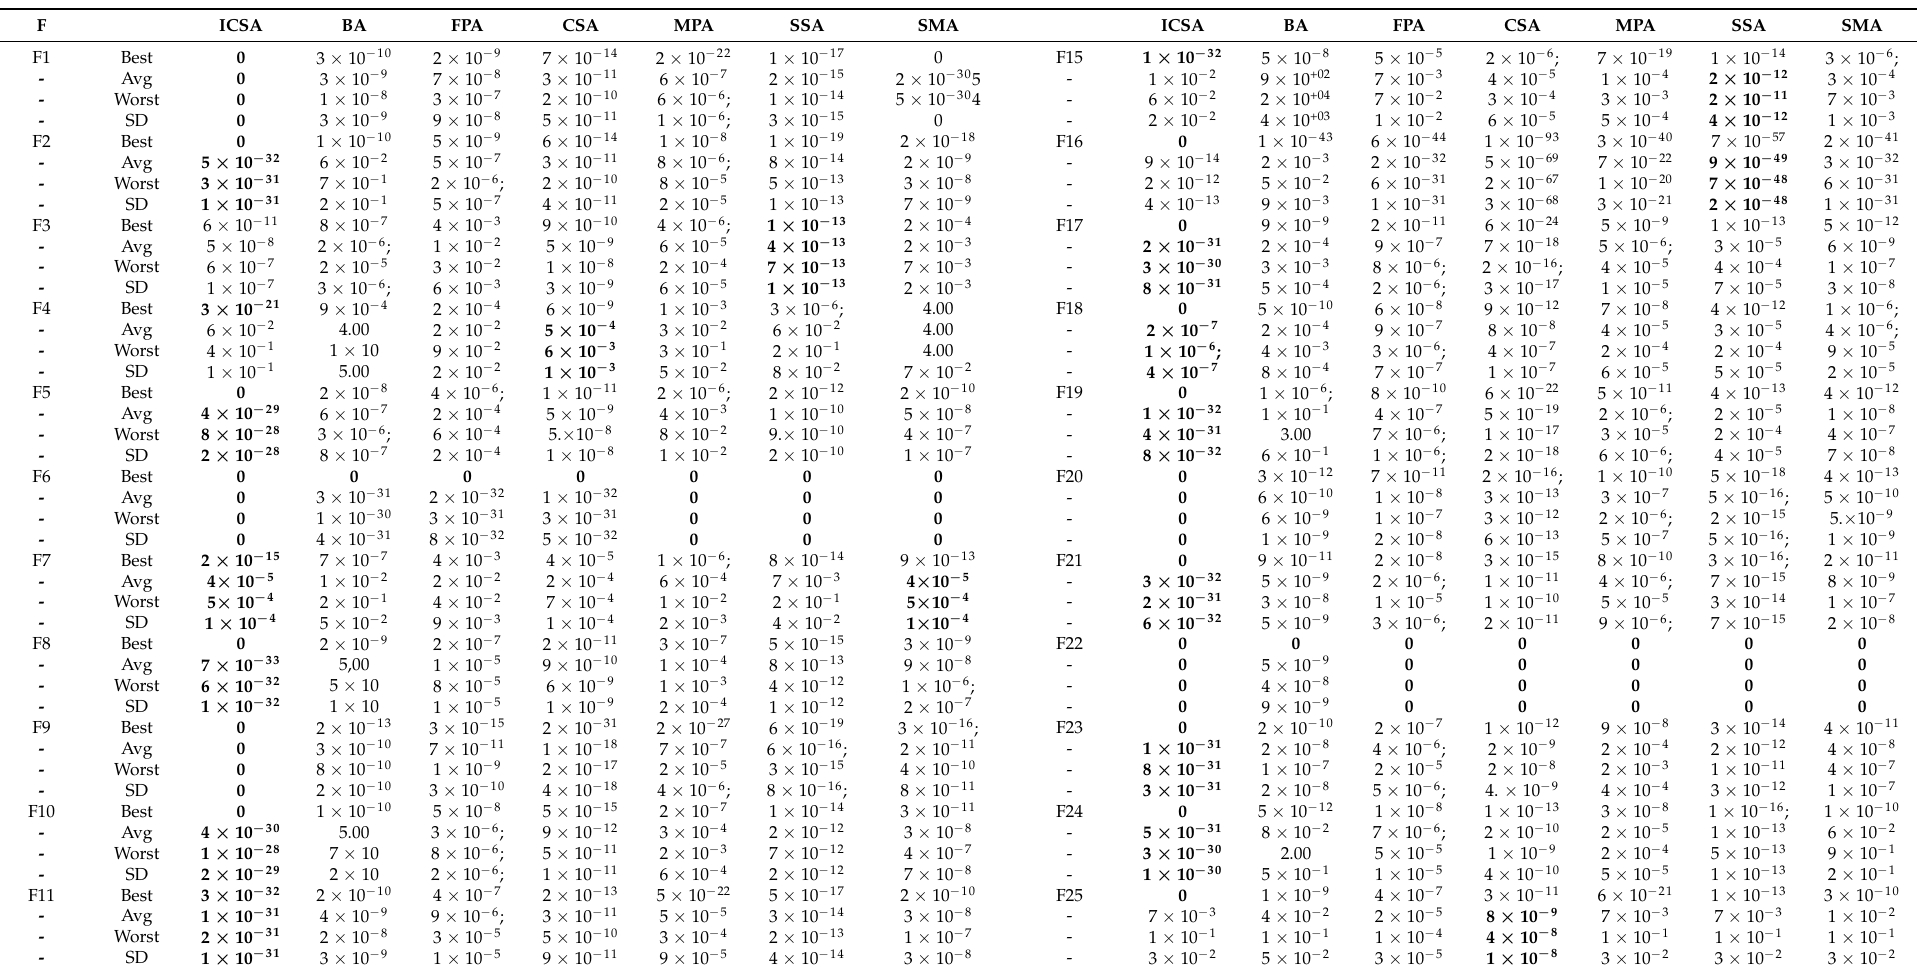
Table 2. Comparison among algorithms on test cases